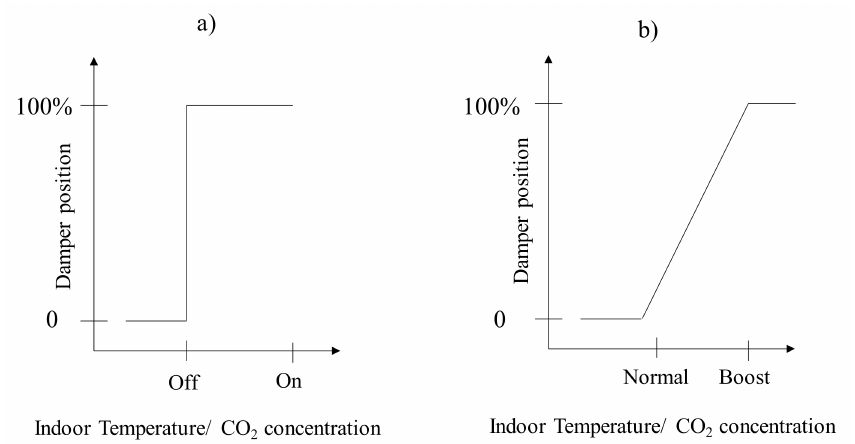
Figure 4. Ventilation control mode: ( a ) ON/OFF control and ( b ) proportional